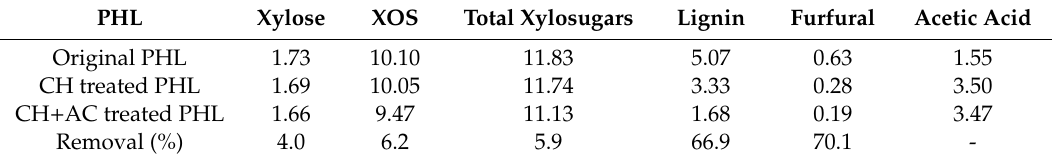
Table 4. PHL compositions at di ff erent treatment stages (g /